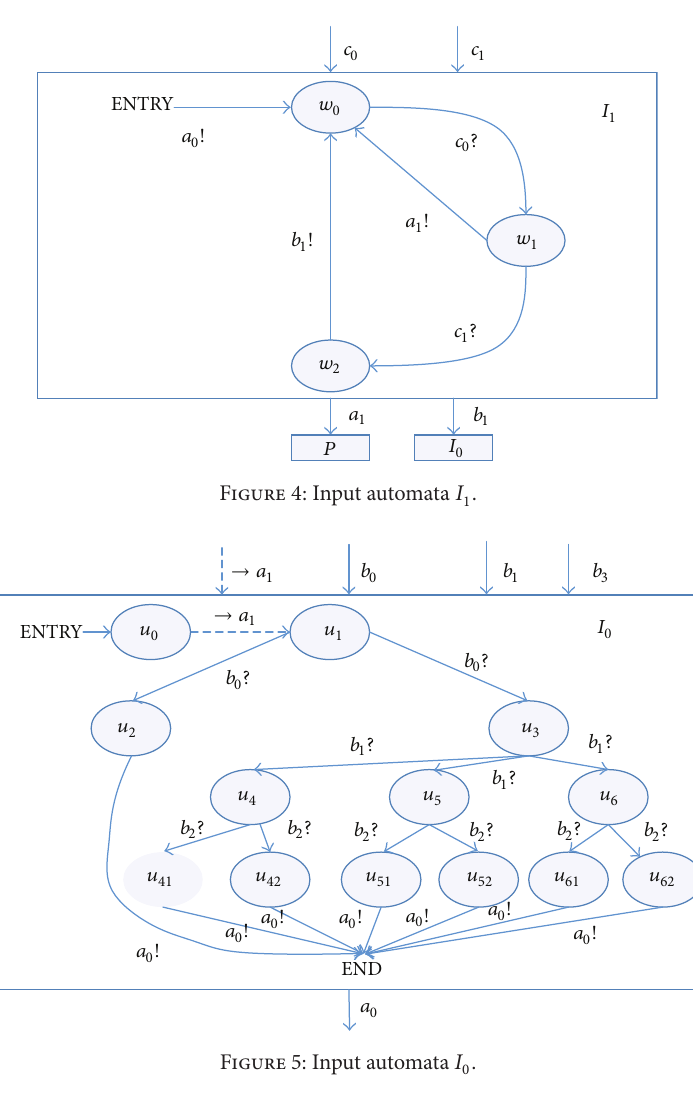
Figure 5: Input automata 𝐼 0